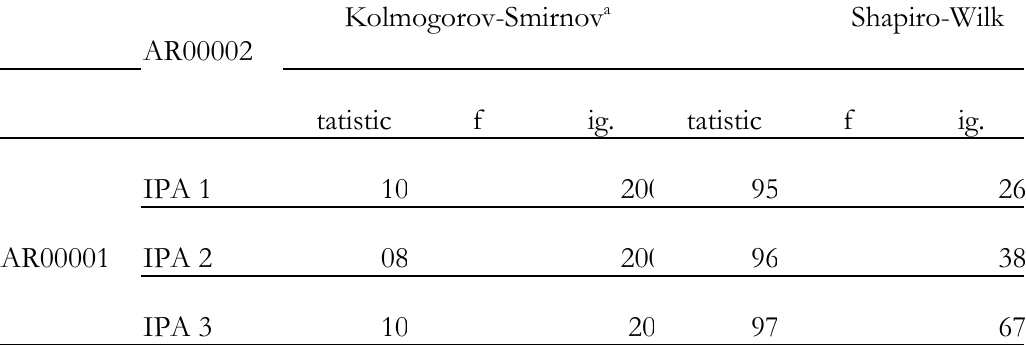
TABLE 3.2 Test of Normality and Test of